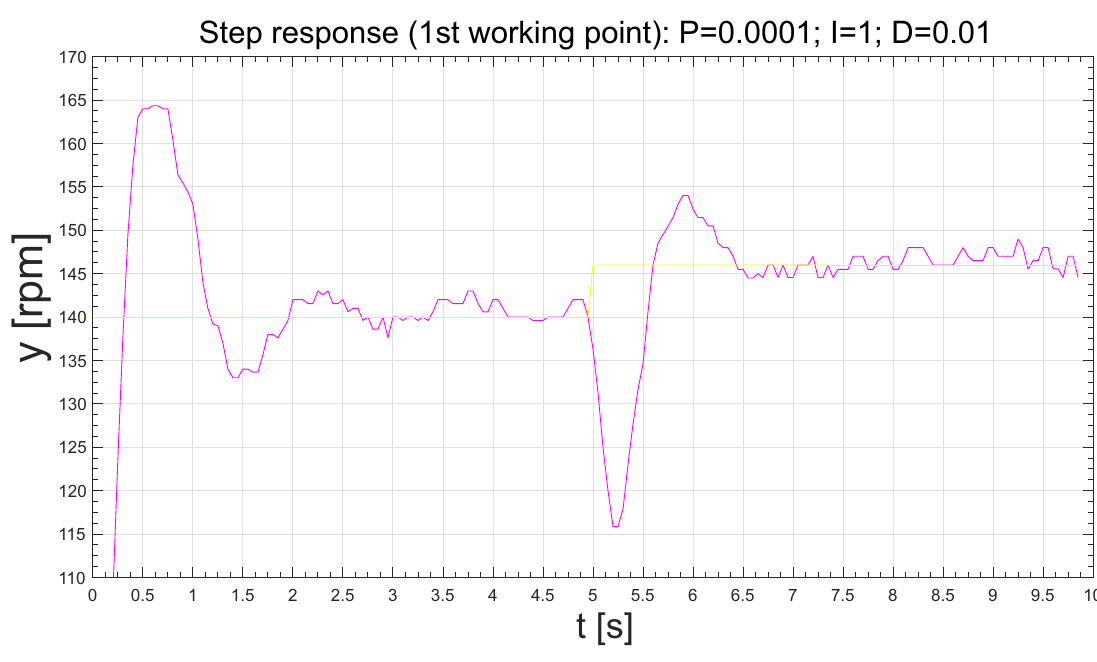
Figure 16. Step response (closed loop)—1st working point—under PID controller.